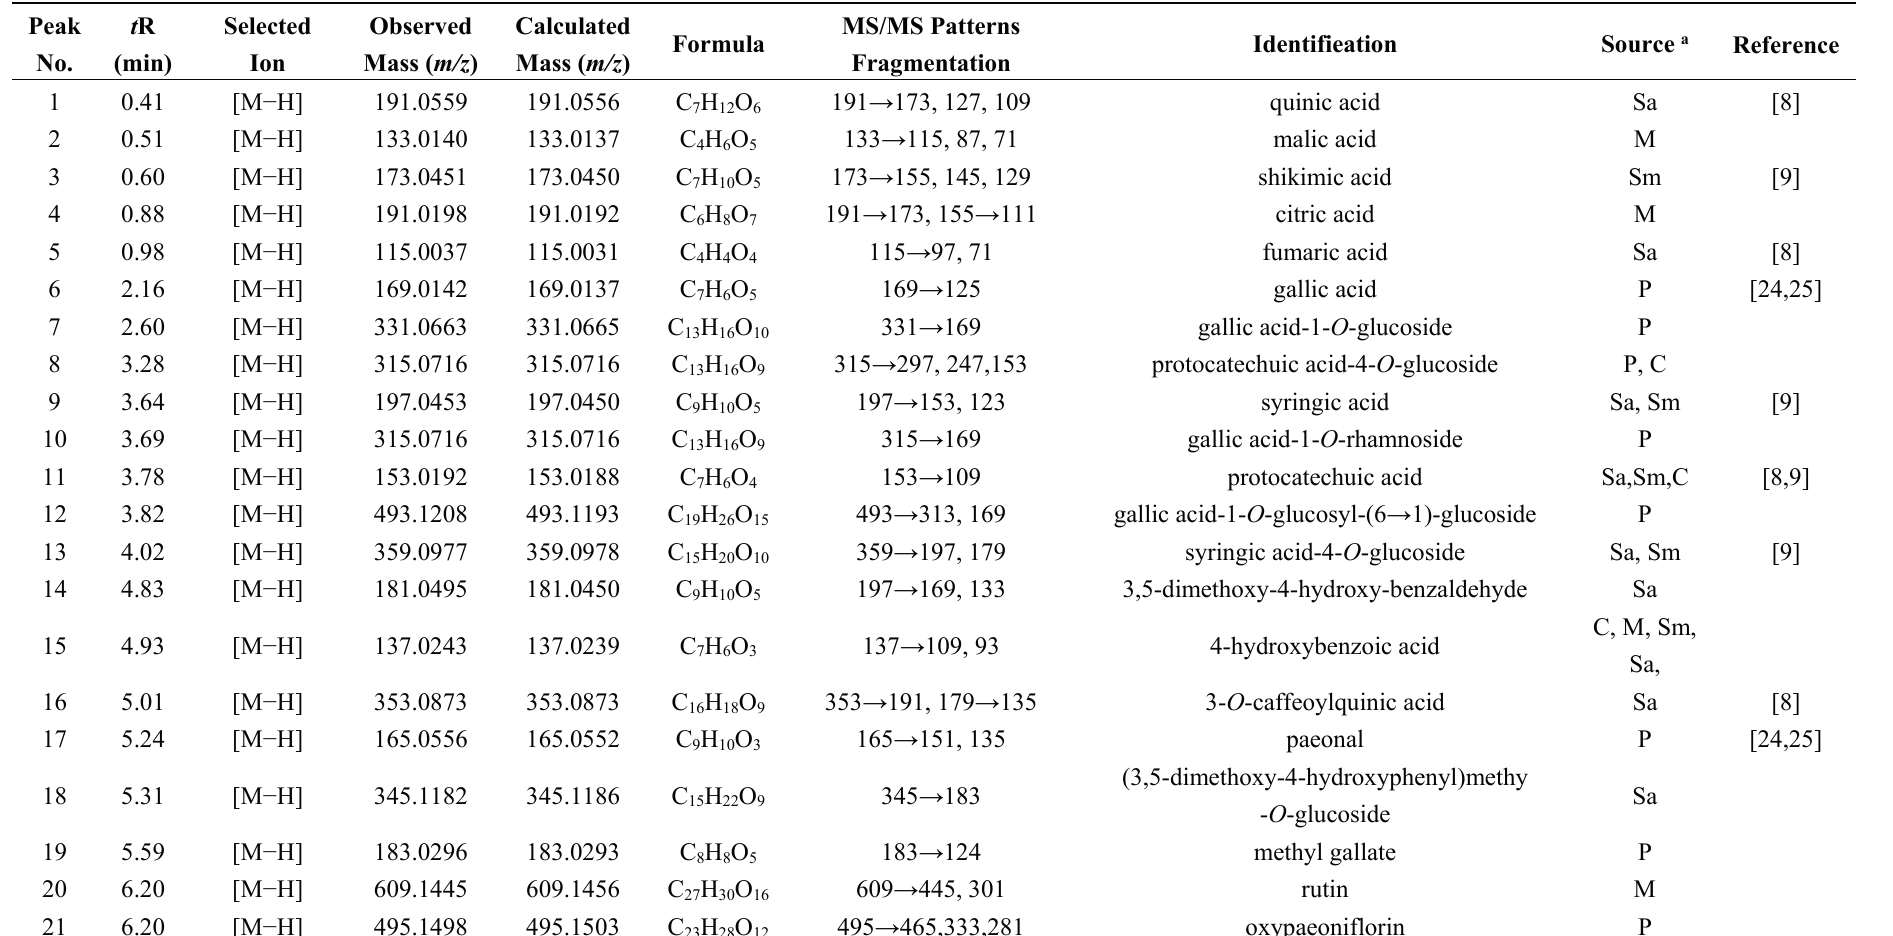
Table 1. Identification of the chemical constituents of PSORI-CM01 by UHPLC-ESI-MS n